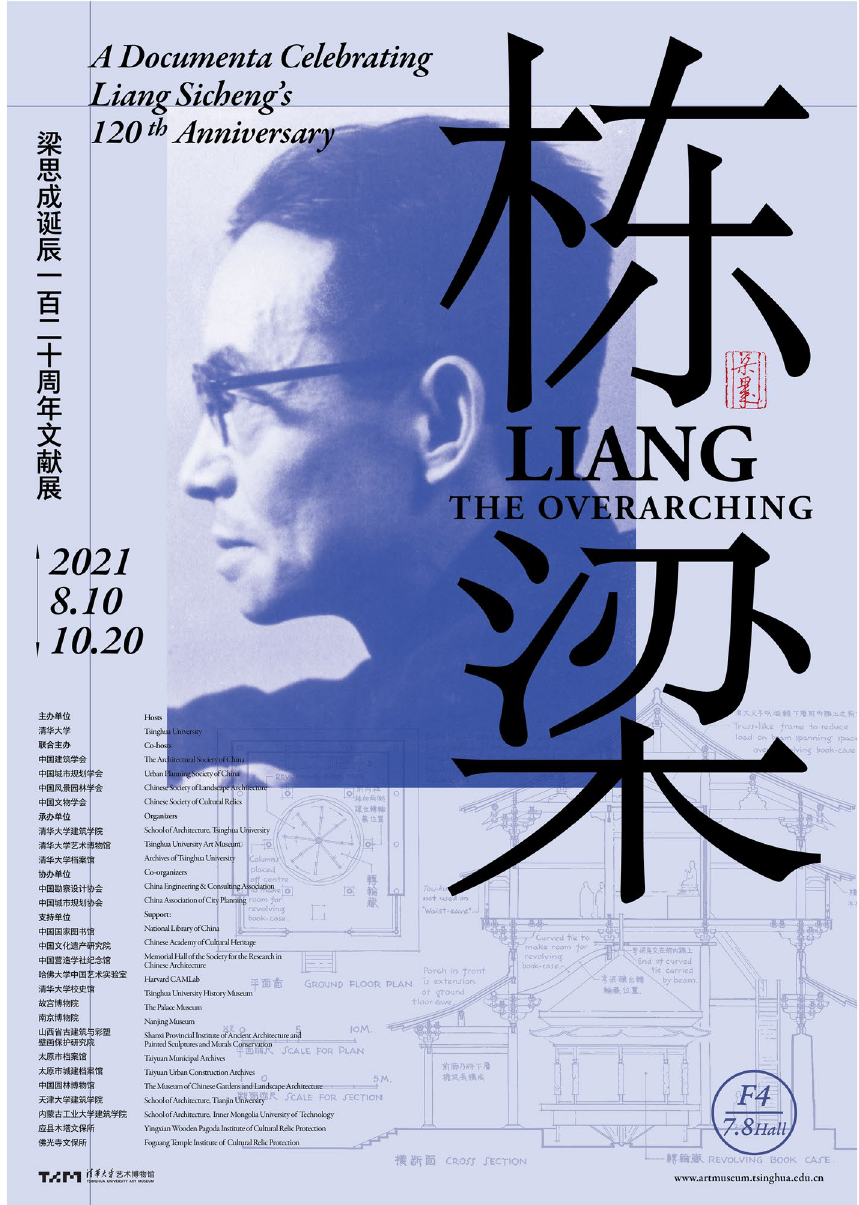
Fig. 1 Exhibition poster (Source: Tsinghua University Art